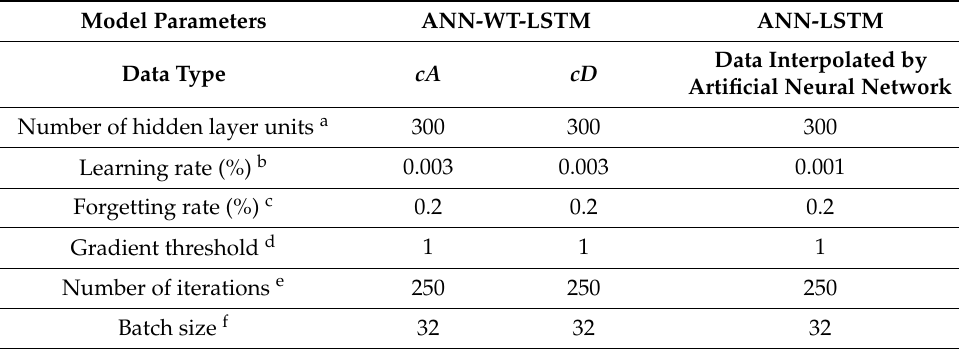
Table 5. Parameter settings of ANN-WT-LSTM and traditional LSTM models.